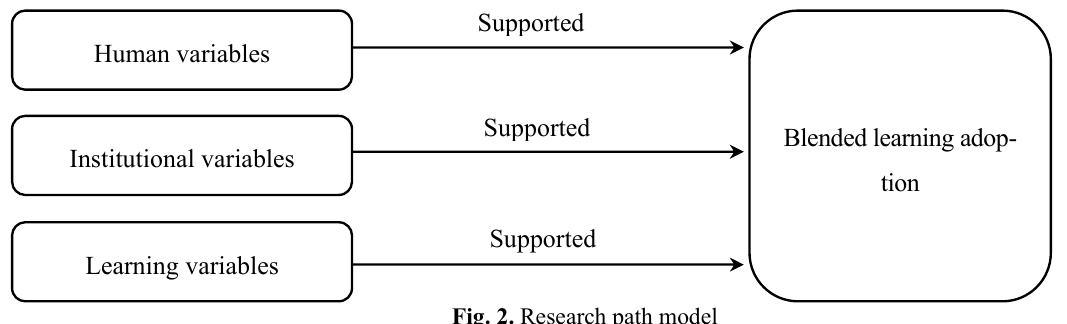
Fig. 2. Research path model